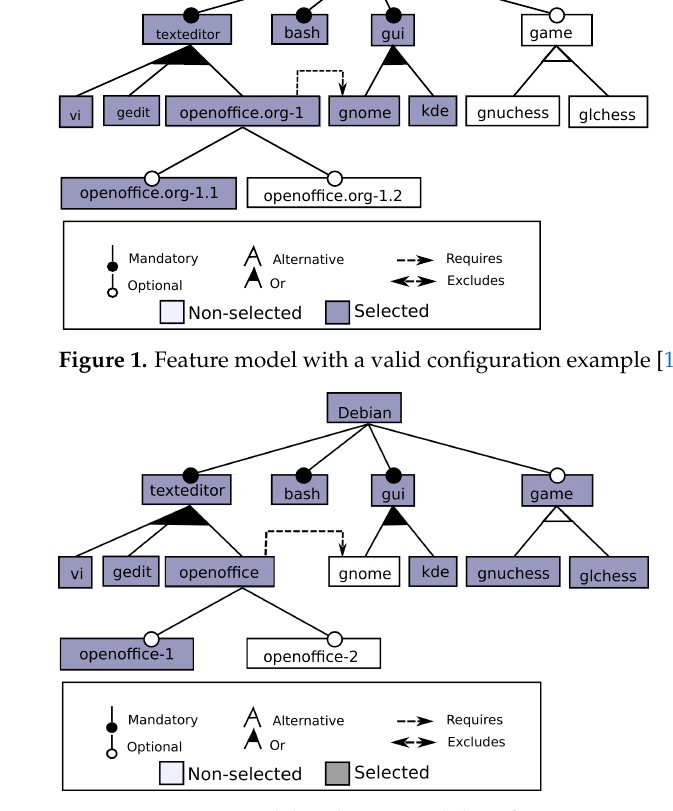
Figure 2. Feature model with a non-valid configuration example